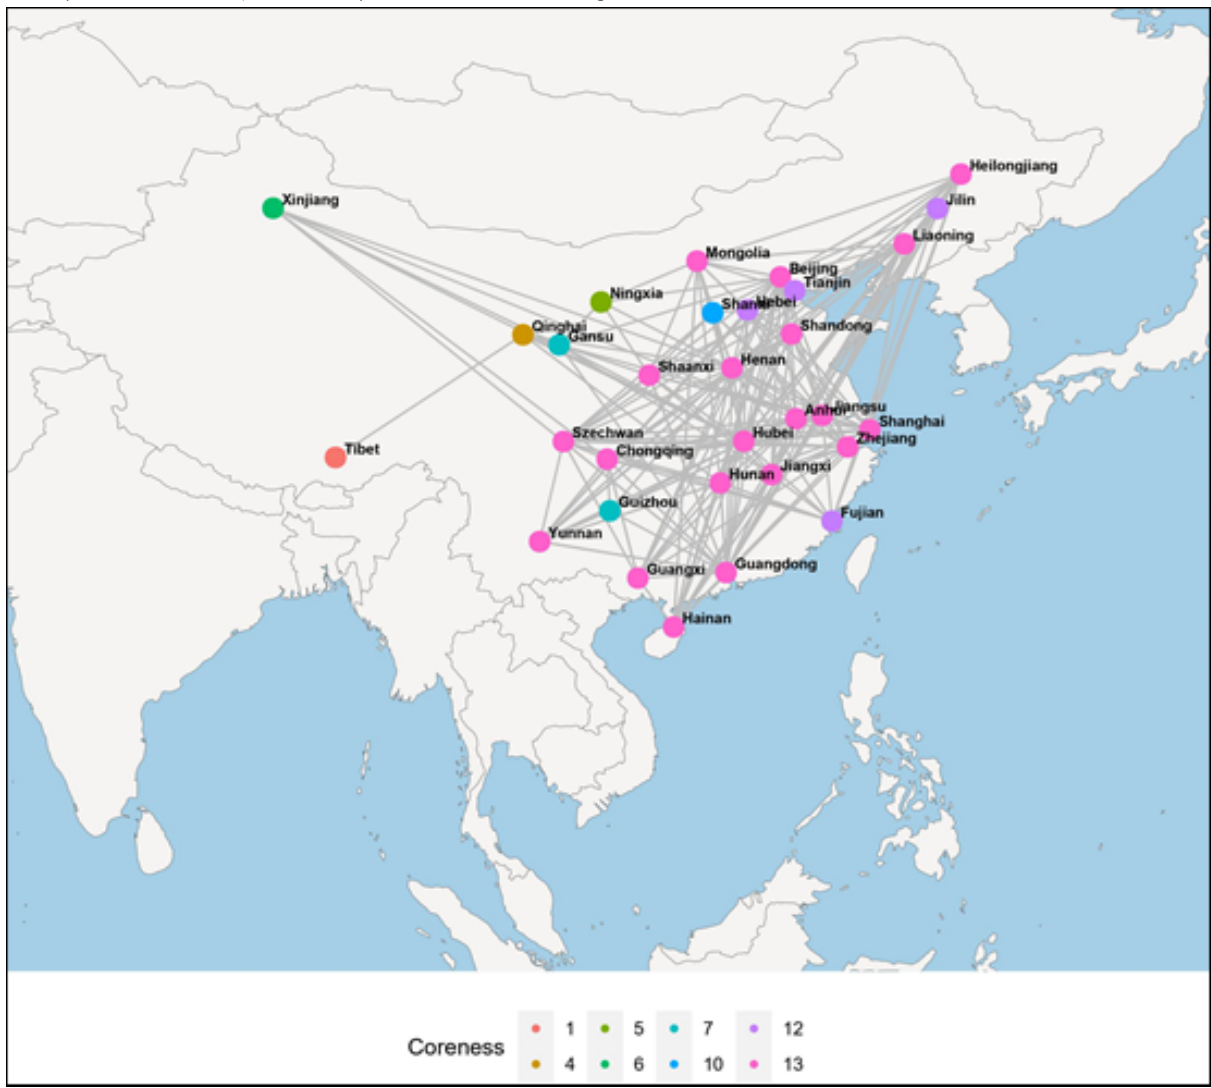
Figure 5. Topological image in geospatial space depicting the network relationship and the coreness of each node over the whole period. The color of the node represents its coreness, which corresponds to the k-shell it belongs